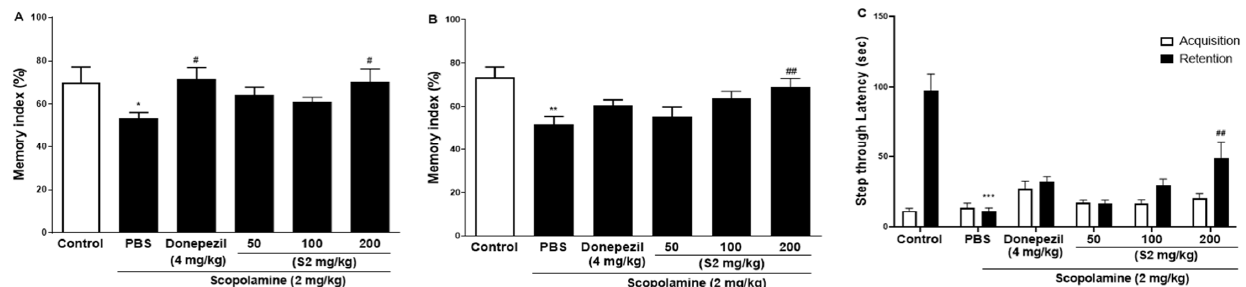
Figure 3. Effect of S2 extract on scopolamine ‐ induced memory deficit in scopolamine ‐ induced mouse. The novel object recognition test (NORT) ( A ), Y ‐ maze ( B ), and passive avoidance test (PAT) ( C ) in mouse model. Values represent the mean ± SEM (n = 5). *: p < 0.01, **: p < 0.05, ***: p < 0.001, the significant difference compared with the control and compared with Scopolamine group, #: p < 0.05, ##: p < 0.01 (one ‐ way ANOVA followed by Dunnett’s multiple comparisons).